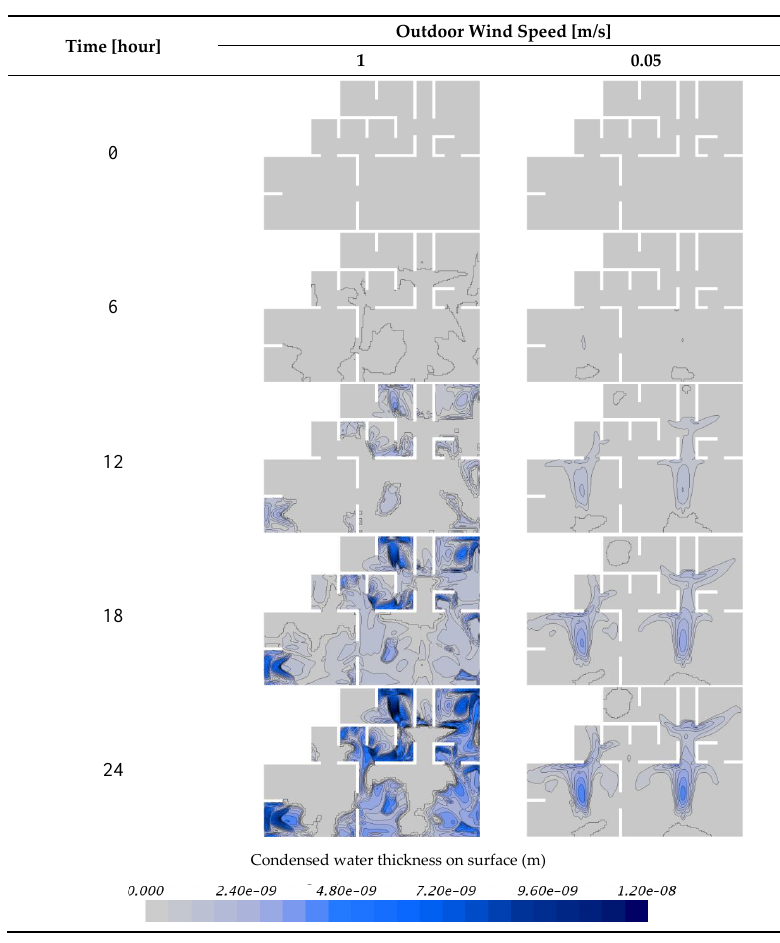
Figure 17. Variation in the condensed water thickness on the surface of the concrete during a